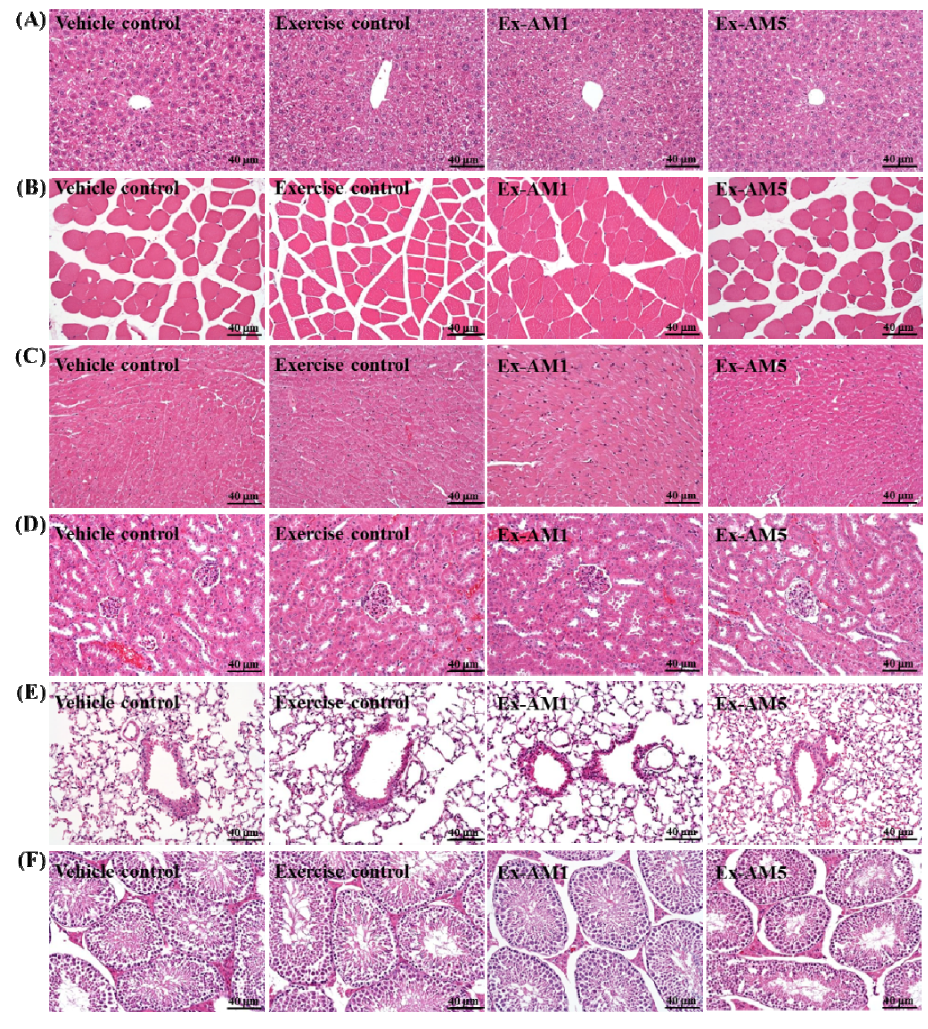
Figure 4. Effect of AM supplementation on morphology of liver ( A ), skeletal muscle ( B ), heart ( C ), kidney ( D ), lungs ( E ), and testes ( F ) tissues. Specimens were photographed under a light microscope. (H&E stain, magnification: ×200, Scale bar, 40 μ